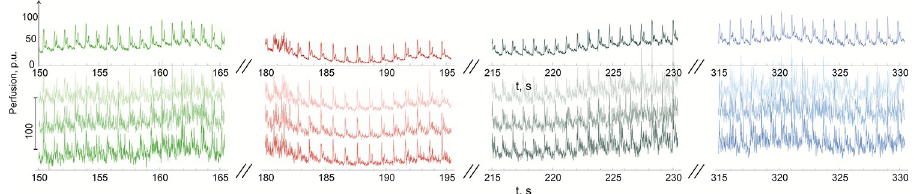
Fig 5. Samples of LSCI perfusion averaged over the total ROI upper curves, and three random roi (3 lower curves) in 4 time intervals. Green curves—LSCI perfusion before the BHT , red—during the BHT , gray—transitional period, blue—recovered perfusion 1.5 min after the BHT